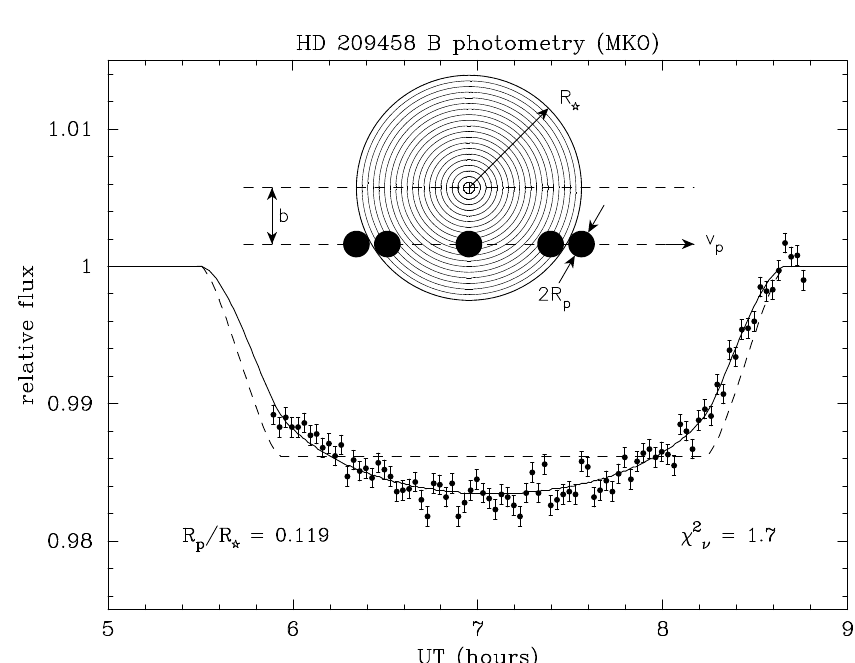
Fig. 11. Geometrical (dashed line) and limb darkening model fits to the transit data of 15 November